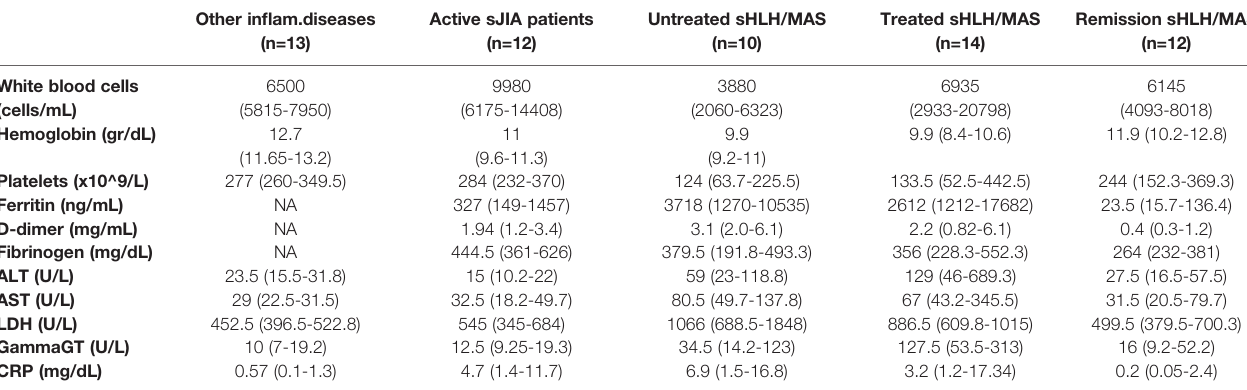
TABLE 1 | Patient laboratory